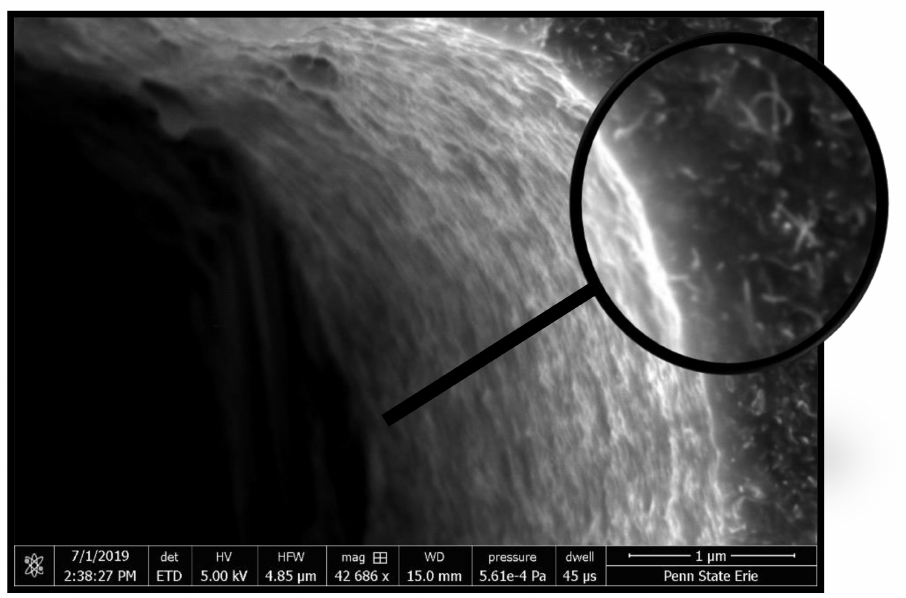
Figure 7. SEM image of the specimen with 50% CF3, 4% carbon nanotube (CNT) content. The zoomed image shows CNT presence around the carbon